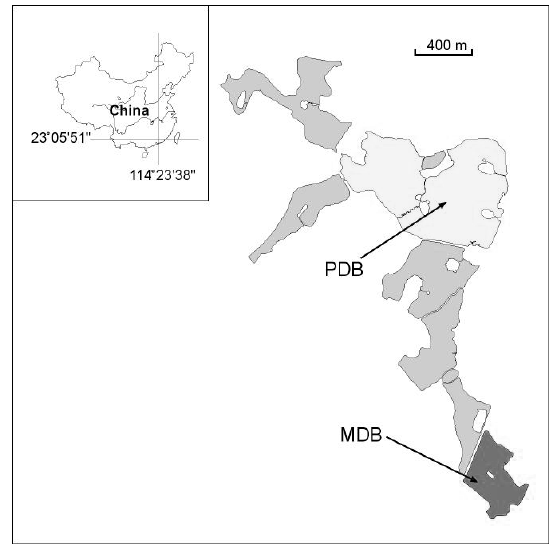
Figure 1. Location of sampling sites in Huizhou West Lake, which is divided into basins by embankments. MDB (dark gray) = restored, macrophyte ‐ dominated basin and PDB (light gray) = unrestored, phytoplankton ‐ dominated basin. Gray denotes other unrestored but not studied basins in Huizhou West Lake.